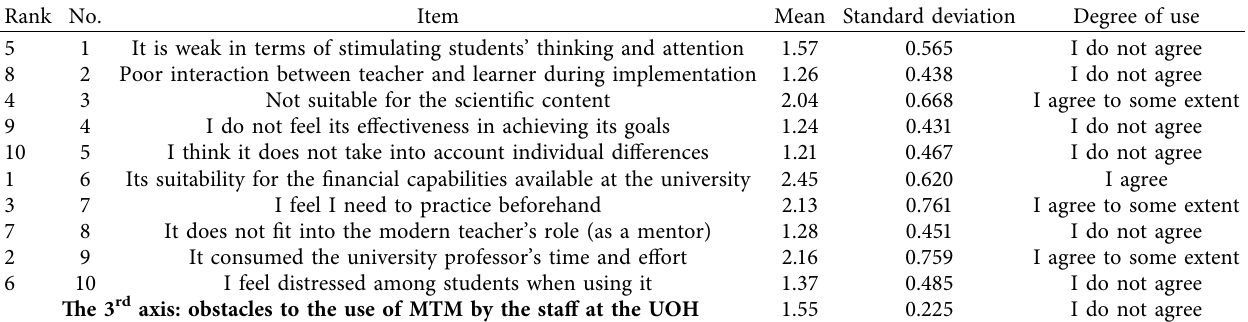
Table 7: The averages and standard deviations of the paragraphs of the questionnaire in the 3 rd axis: obstacles to the staff’s use of MTM at the UOH. Rank